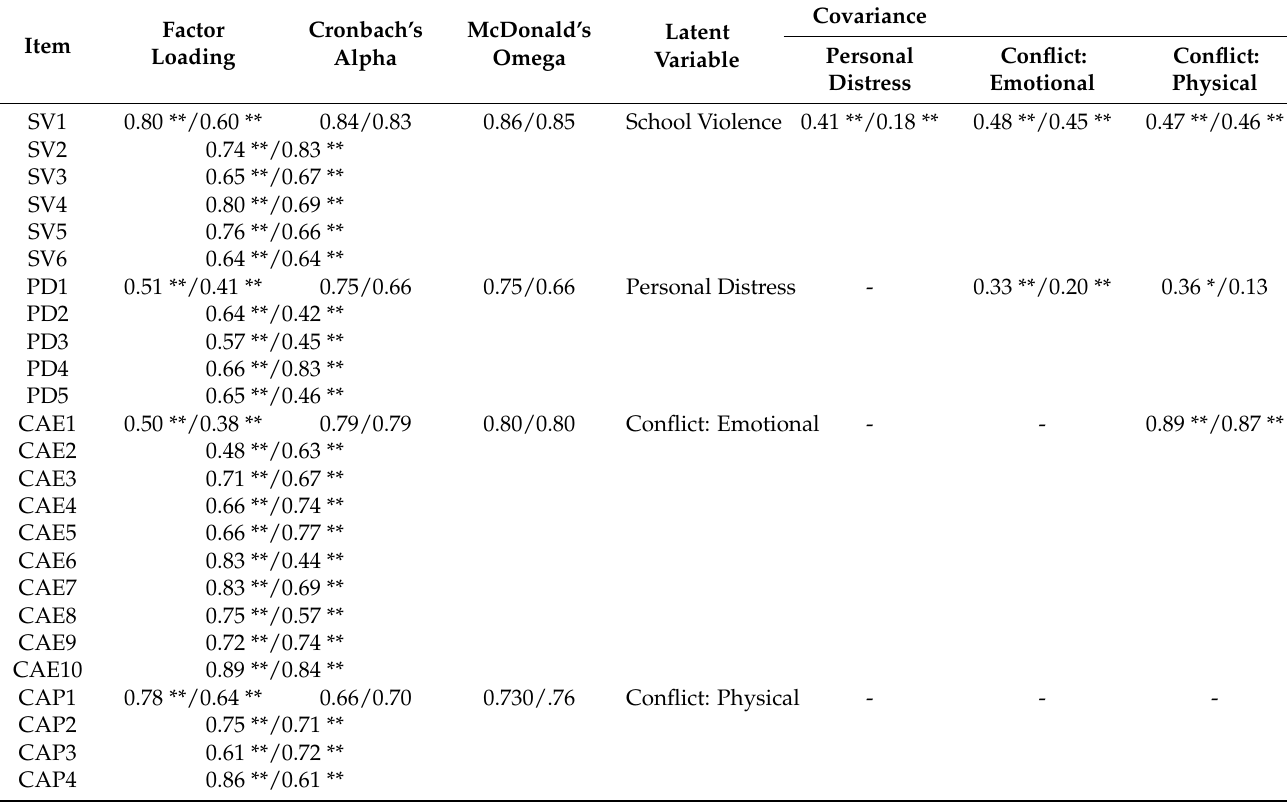
Table 3. Factor loadings, Cronbach’s Alpha, McDonald’s omega coefficients and covariances between latent variables on the measurement model for